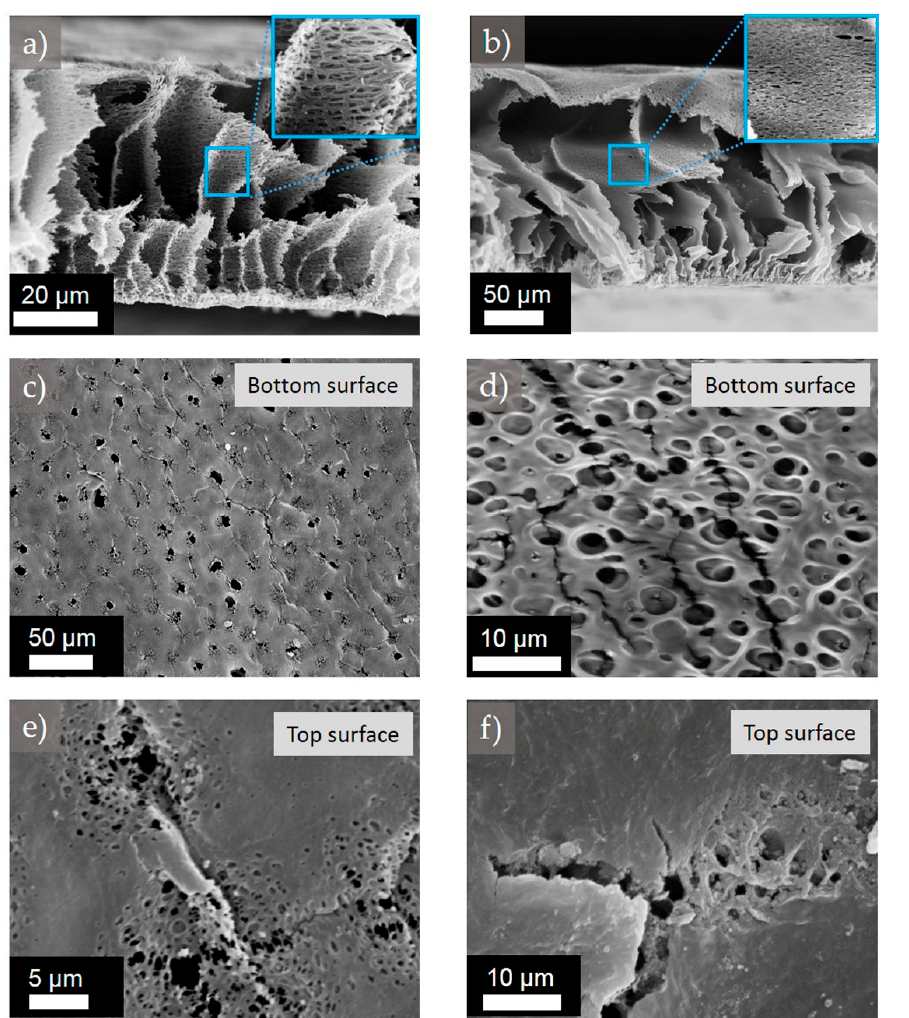
Figure 7. Representative SEM images of the cross-section, the top and the bottom surfaces of the membranes ( a ), ( c ), ( e ) M0-6 and ( b ), ( d ), ( f ) M0-12.